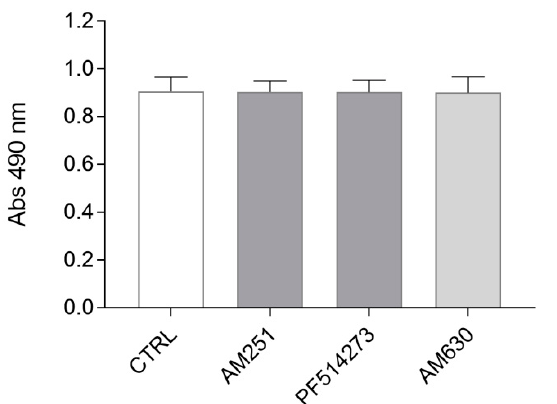
Figure 2. Evaluation of CB1/CB2 blockade effects on ST14A cell number. ST14A were treated for 24 h with 250 nM AM251 or 50 nM PF514273 (CB1 antagonists), or 300 nM AM630 (CB2 antagonist), then an MTS assay was performed. No effect on ST14A cell number was observed in treated cells, in respect to control (CTRL, medium plus 0.05% DMSO). Data from the MTS assay are expressed as mean ± standard deviation (SD) of the absorbance ( λ = 490 nm); n = 8 replicates, 3 independent experiments.